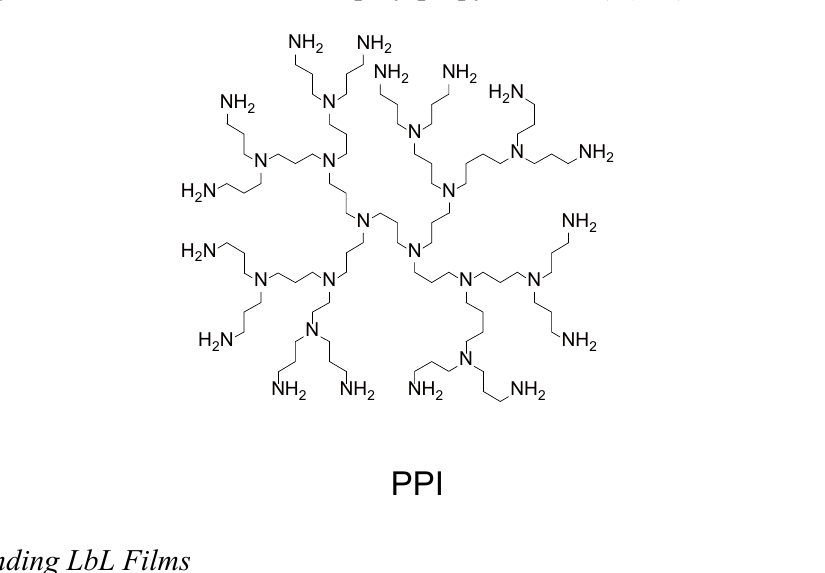
Figure 4. Chemical structure of poly(propyleneimine) (PPI)